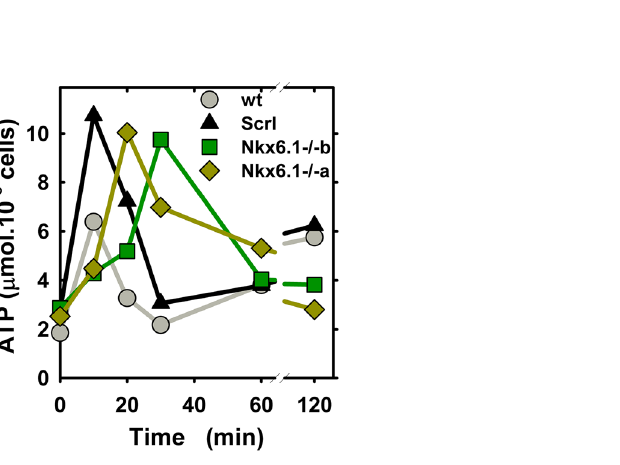
Figure 2. Time course of ATP elevation after 3 to 20 mM glucose adjustment—relative ATP amounts assayed by bioluminescence after adjustment of glucose from 3 to 20 mM are plotted for parental INS-1E cells (wt, gray ), INS-1E scrl/scrl cells ( black ) and line ( a ) ( yellow green ) and line ( b ) of INS-1E Nkx6.1 – / – cells ( green